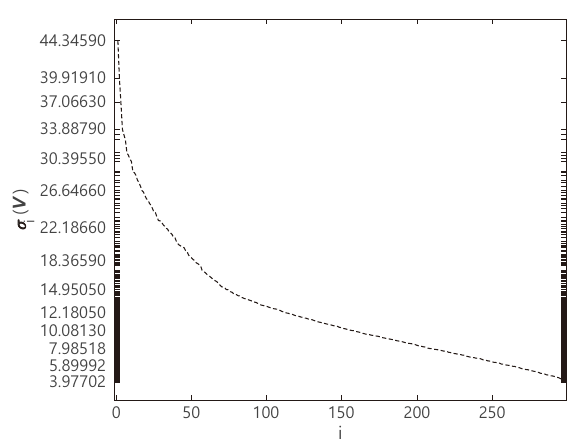
Fig. 3 Spectrum of the background error deviance matrix V